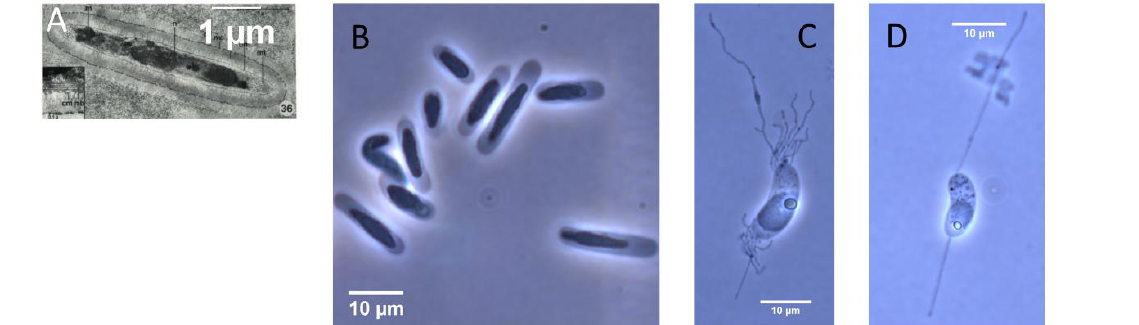
Figure 2: Examples of sperm morphologies in the Daphniidae . A- Ceriodaphnia laticauda , small and encapsulated elongated sperm (blue color in figure 1) representative of one of the species used as outgroup. Photo from Wingstrand (1978). B- D. magna , large and encapsulated elongated sperm (blue color in figure 1); C and D - D. longispina , two examples of typical non-encapsulated and elongated sperm with filopodia (green color in figure